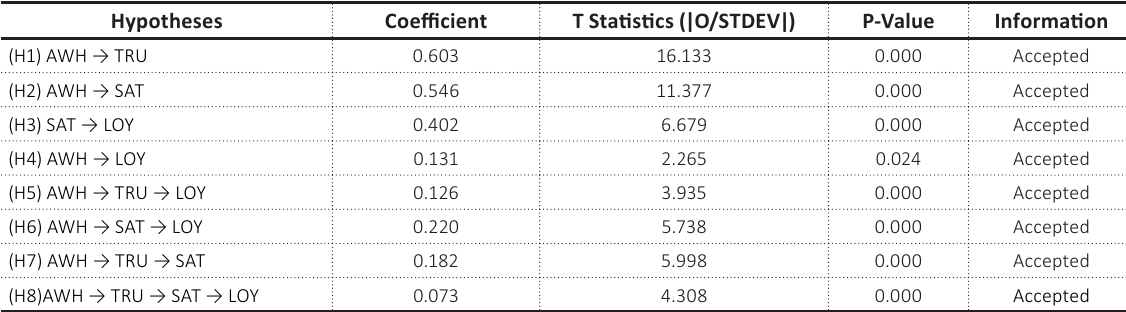
Table 6. Hypothesis testing